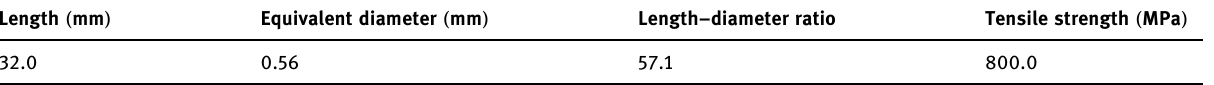
Table 4: Properties of